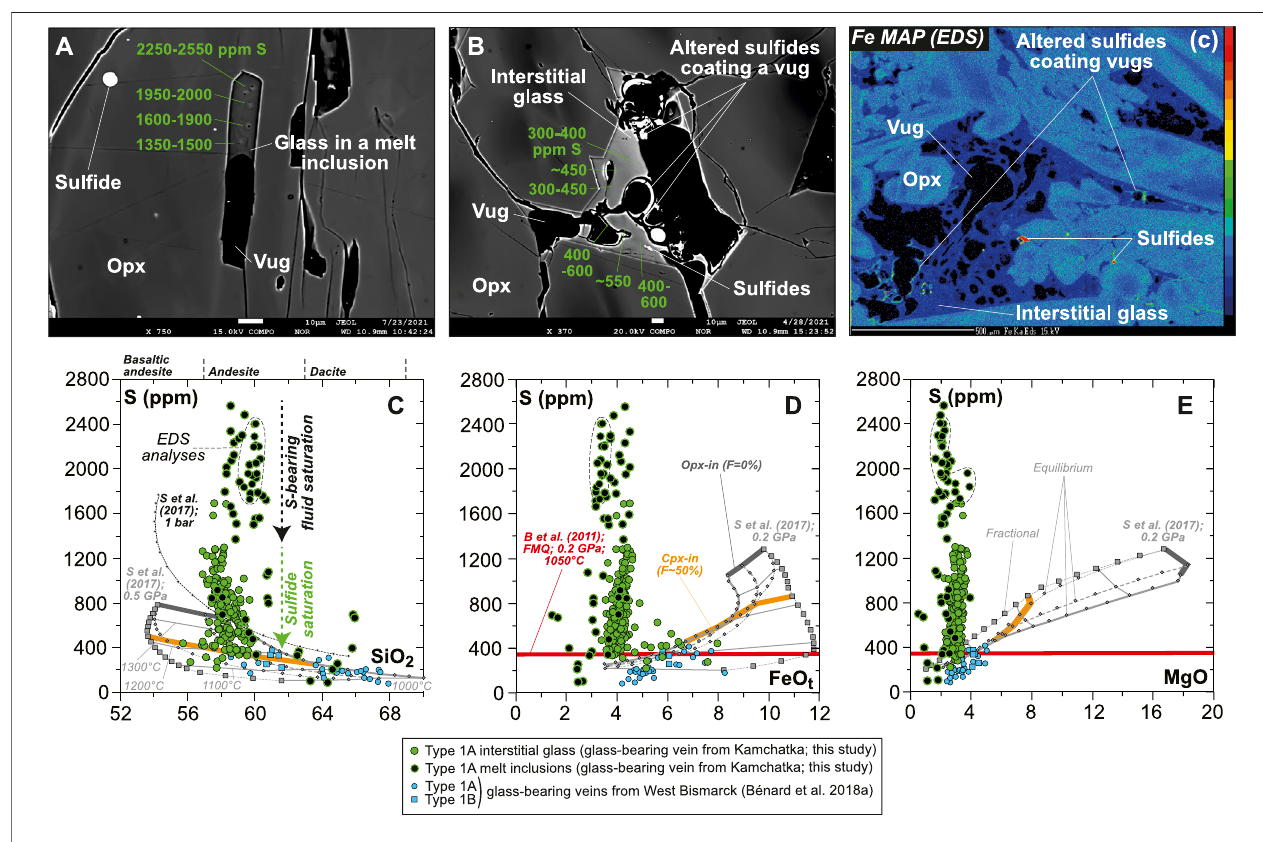
FIGURE 9 | Sulfur composition for the new Kamchatka vein in this study (glass and melt compositions are normalized on an anhydrous basis). (A,B) BSE images (EPMA) showing local variations in S abundances (in green) in (A) a MI and (B) interstitial glass. Note that S abundances in the glass of the sul fi de-free MIs decrease toward the vug. (C) A Fe map (EPMA) showing the distribution of sul fi des and Fe oxyhydroxide coating vugs ( Fig. S9 ). Scale bar is 10 μ m in (A,B) and 500 μ m in (C) . (C – E) S abundances in vein MIs and interstitial glass plotted against oxide compositions (in wt%). Also shown in (C – E) are SCSS calculated with the model of Smytheetal.(2017)at (C) 1 barand0.5 GPa(blackandgraylines,respectively)and (D,E) 0.2 GPa(graylines).MeltmajorelementcompositionsusedtocalculateSCSS are those of isobaric models for the liquid lines of descent of harzburgite-derived melts at 1 GPa, calculated by Bénard et al. (2018a) with pMELTS. Note the more consistent fi ts of those models for West Bismarck glass than for Kamchatka glass (see text for details).